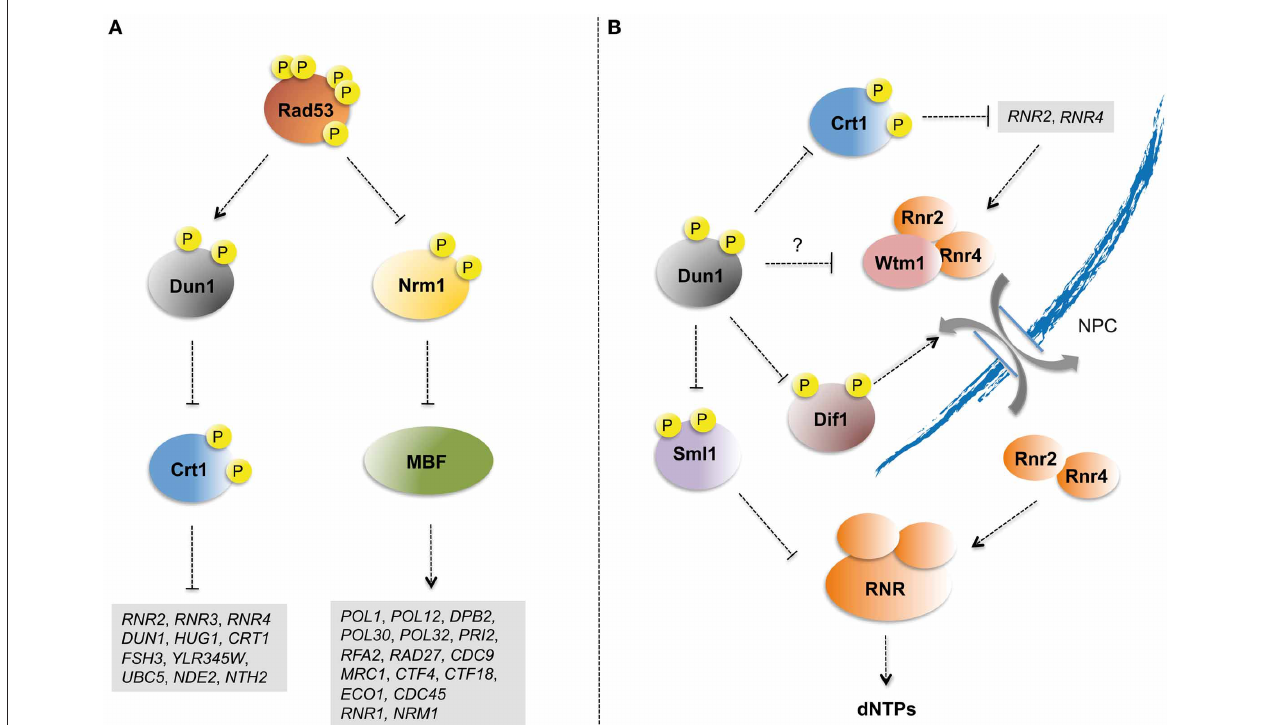
FIGURE 2 | Checkpoint control of S phase transcription and dNTP pools. (A) Rad53 kinase controls the transcriptional activation of Crt1-repressed damage-inducible and G1/S transition MBF genes in response to replication stress. The transcriptional repressor Crt1 is phosphorylated in a Rad53- and Dun1-dependent manner and displaced from the promoters of damage-inducible genes. Rad53 also phosphorylates the MBF-specific repressor Nrm1 allowing the expression of G1/S transition genes. Relevant genes with roles including dNTP pool regulation, checkpoint response, DNA replication, and DNA repair that are induced following replication stress in a checkpoint-dependent manner are listed.